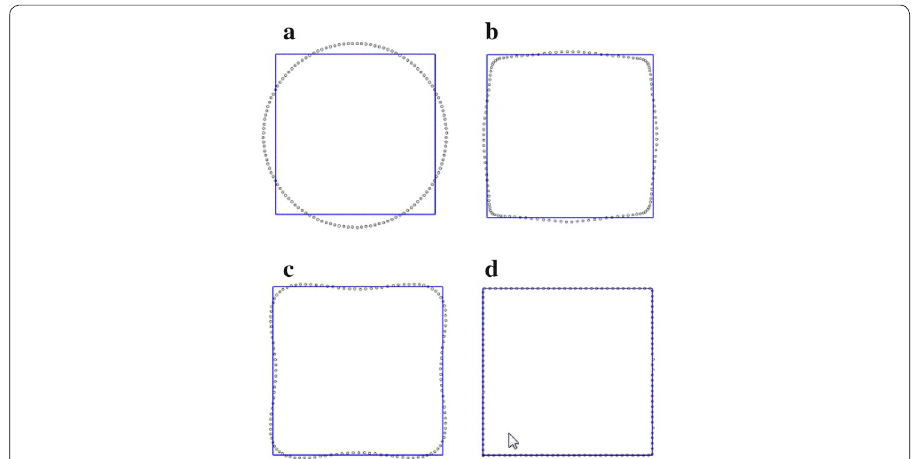
Fig. 3 The importance of high order Fourier descriptors in the reconstruction of a simple shape, a square: a c B (0) and c B (1) only; b c B (0) 128 descriptors